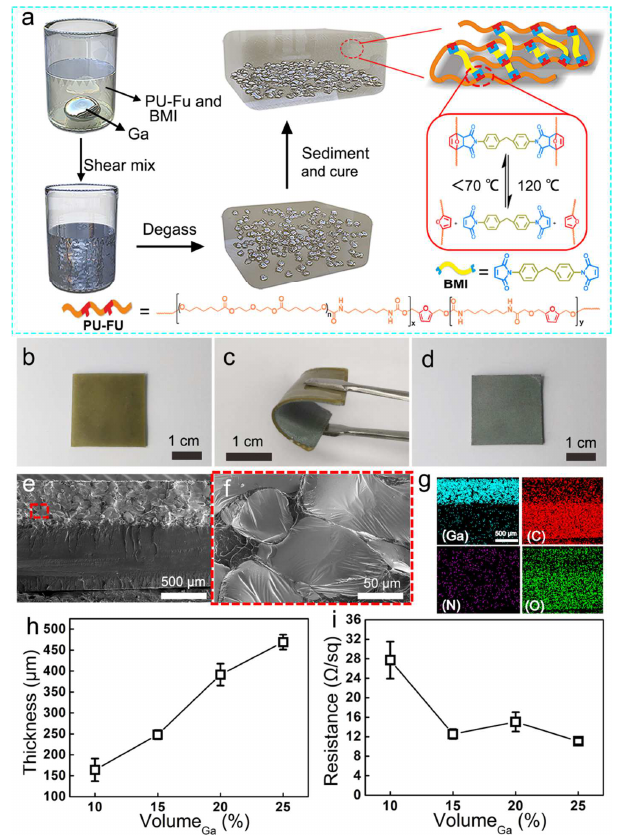
Figure 1. Fabrication and characterization of bilayer-structured Ga–PU composites. ( a ) Schematic illustration of the fabrication procedure of the composites, together with a schematic depiction of the elastomer structure and the mechanism of the formation and dissolution of the dynamic DA bonds. ( b – d ) Optical photographs of the as-fabricated Ga–PU composite (15 vol% Ga): ( b ) elastomer-rich layer, ( c ) flexibility of the composite, and ( d ) Ga-rich layer. ( e – f ) SEM micrographs and ( g ) EDS mapping of the cross-section of one representative composite (25 vol% Ga); the upper area is